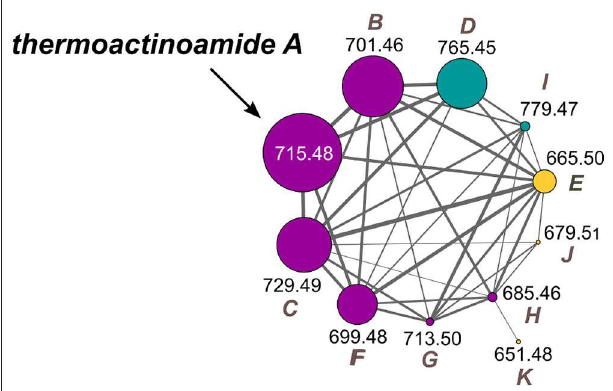
FIGURE 2 | Molecular cluster of thermoactinoamides. Nodes for thermo- actinoamides containing one aromatic residue are labeled in purple, while thermoactinoamides containing two and no aromatic residue are marked in blue and orange, respectively. Node size is relative to the areas of the relevant peaks in the extracted-ion chromatograms from the LC-MS run and edge thickness is relative to the cosine score similarity.